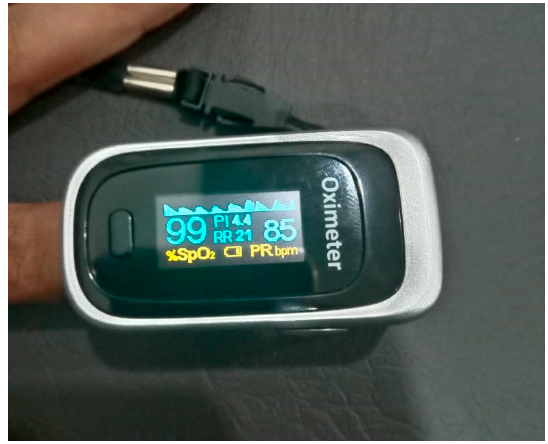
Figure 7. Pulse oximeter. Table 1. Validation results.